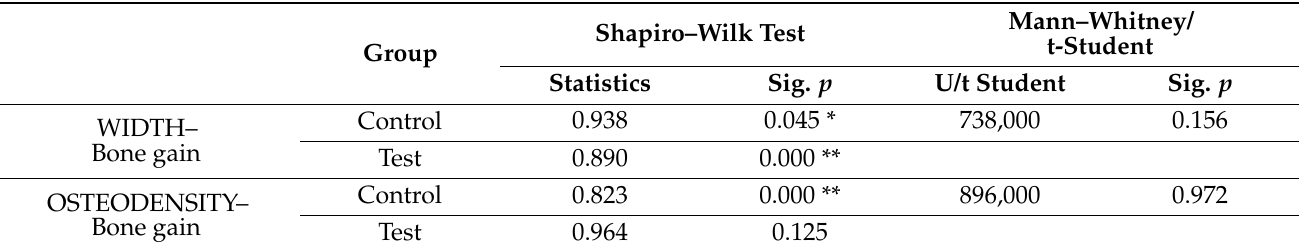
Table 4. Mann–Whitney test. Intergroup statistical comparisons (control vs. test group). (Bone gain: height, width,